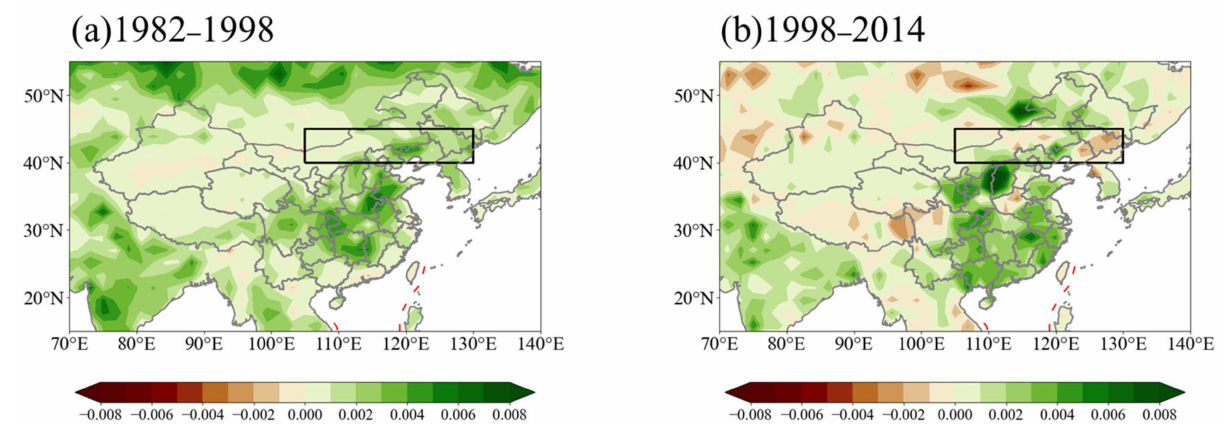
Figure 2. Analysis of growing season NDVI trends for different periods. Note: Brown color represents a decreasing trend, and green color represents an increasing trend. The red dashed lines in the figure represent Ten-dashed lines. The numbers below the description of the colors represent the trend slope value. The black box in it is defined as the northeastern region of East Asia (40~45 ◦ N, 105~130 ◦